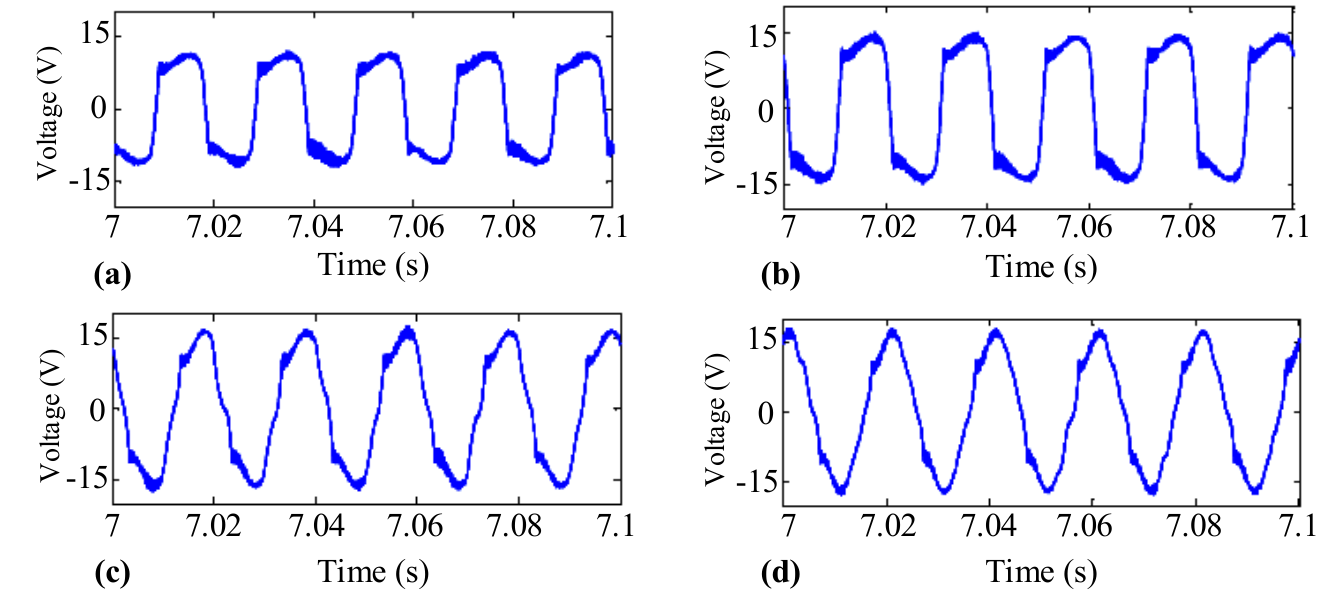
Figure 18. Output voltage changes in the first scenario using ( a ) the first strategy, ( b ) the second strategy, ( c ) the third strategy, and ( d ) the fourth strategy.